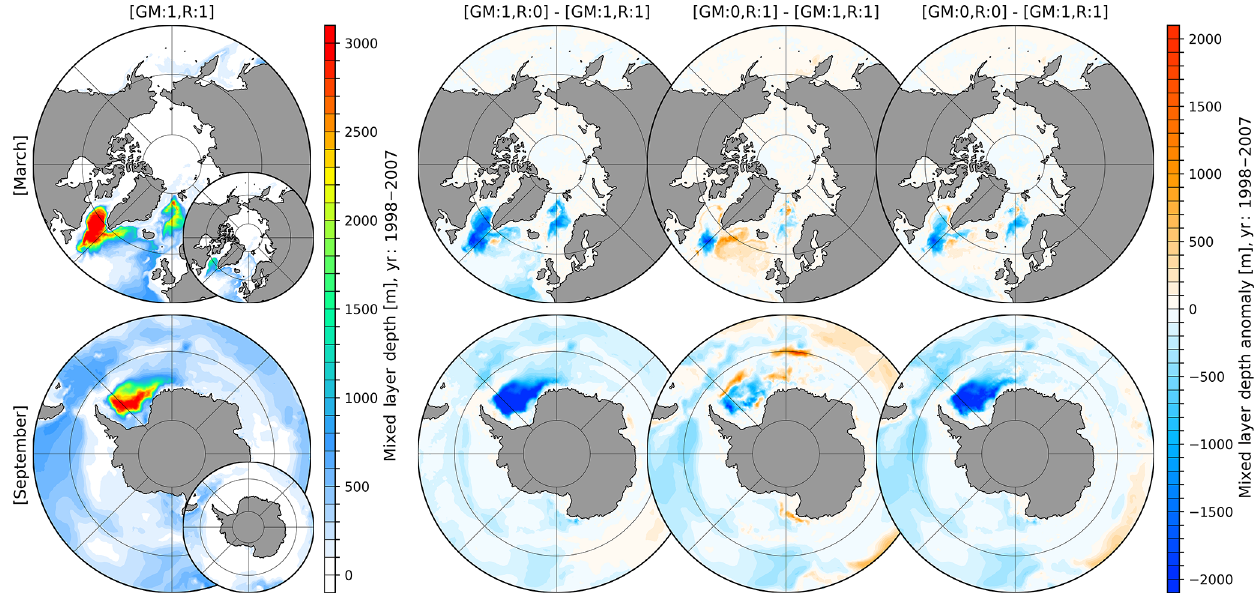
Figure 9. First column: March (upper row) and September (lower row) mean mixed layer depth (MLD, definition after Monterey and Levitus, 1997) for the simulation with switched on (:1) Gent–McWilliams (GM) parameterization and Redi (R) diffusion averaged over the period of 1998–2007. Second to fourth columns: anomalous MLD of simulations with either switched off (:0) GM or R, or both switched off with respect to the control simulation where GM and R are both switched on. The small inset plots show the MLD after the definition of Large et al.